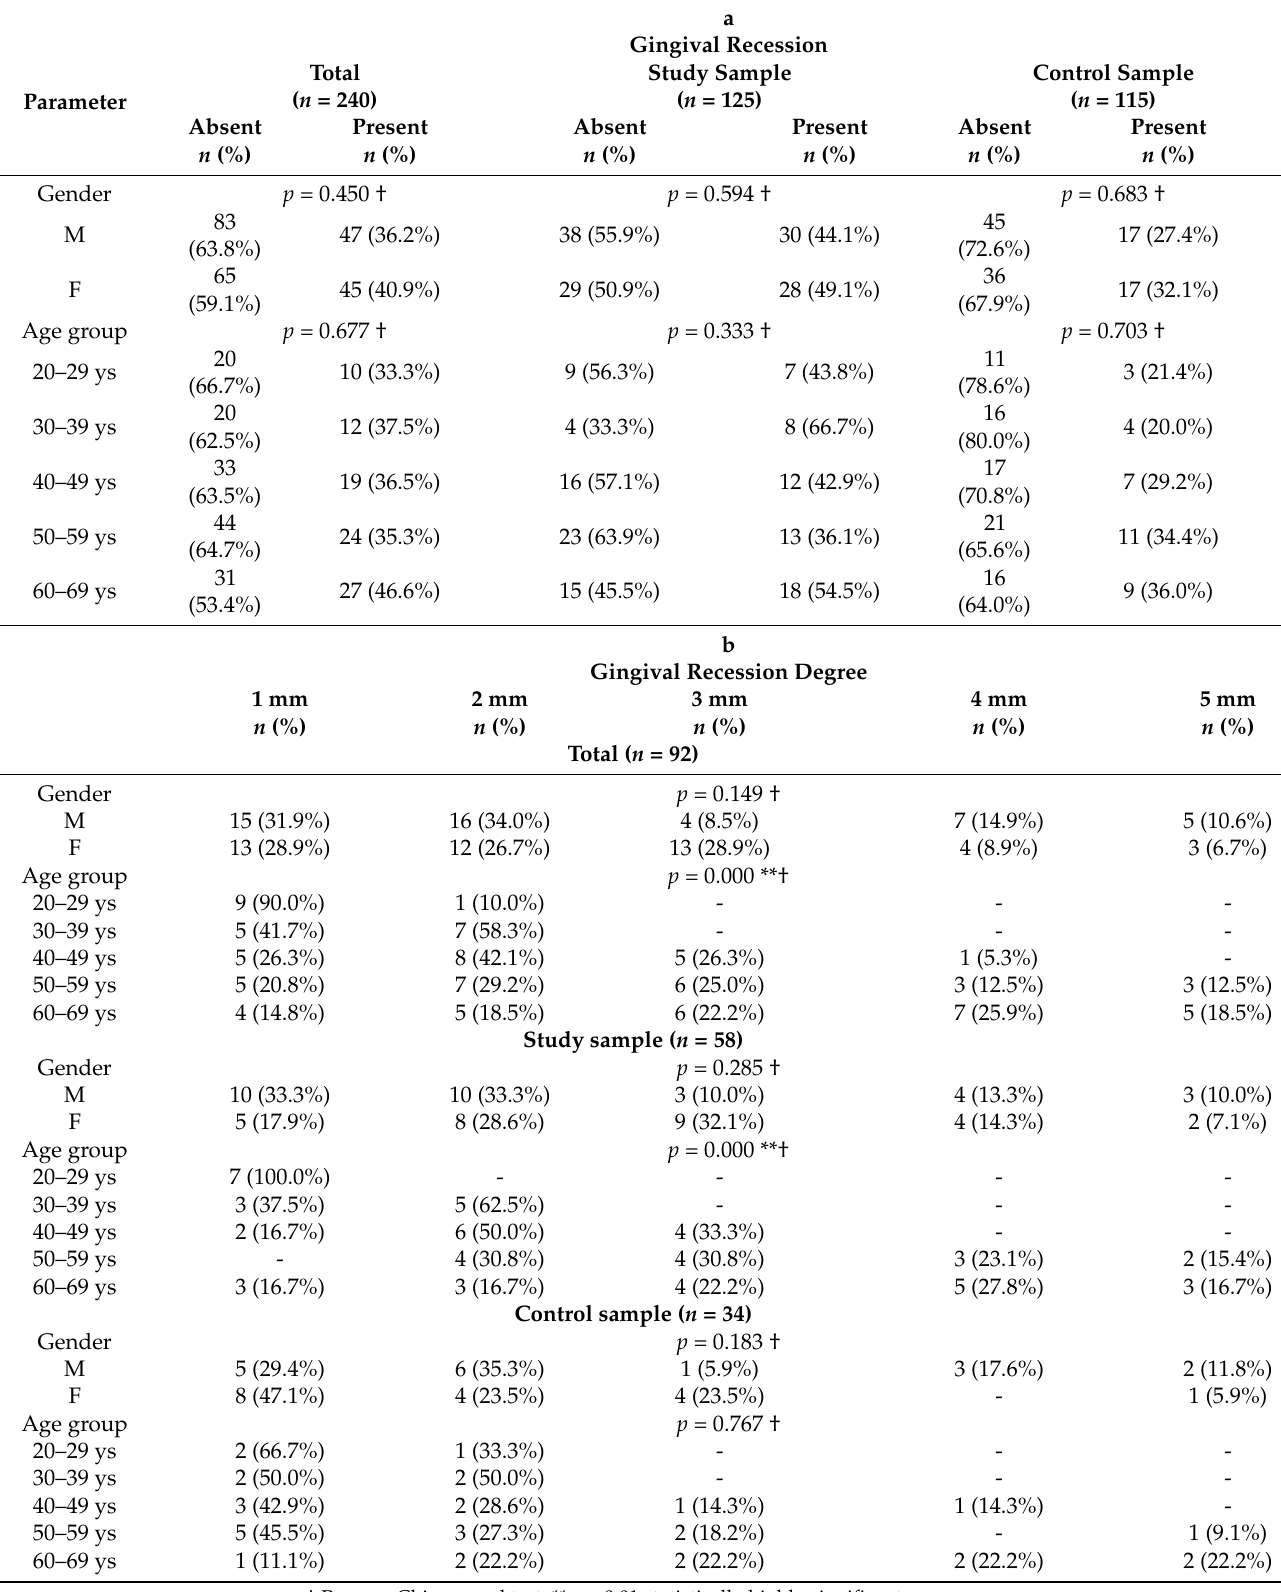
Table 3. a. The gingival recession presence by genders and age groups in the investigated samples. b. The gingival recession degree by genders and age groups in the investigated